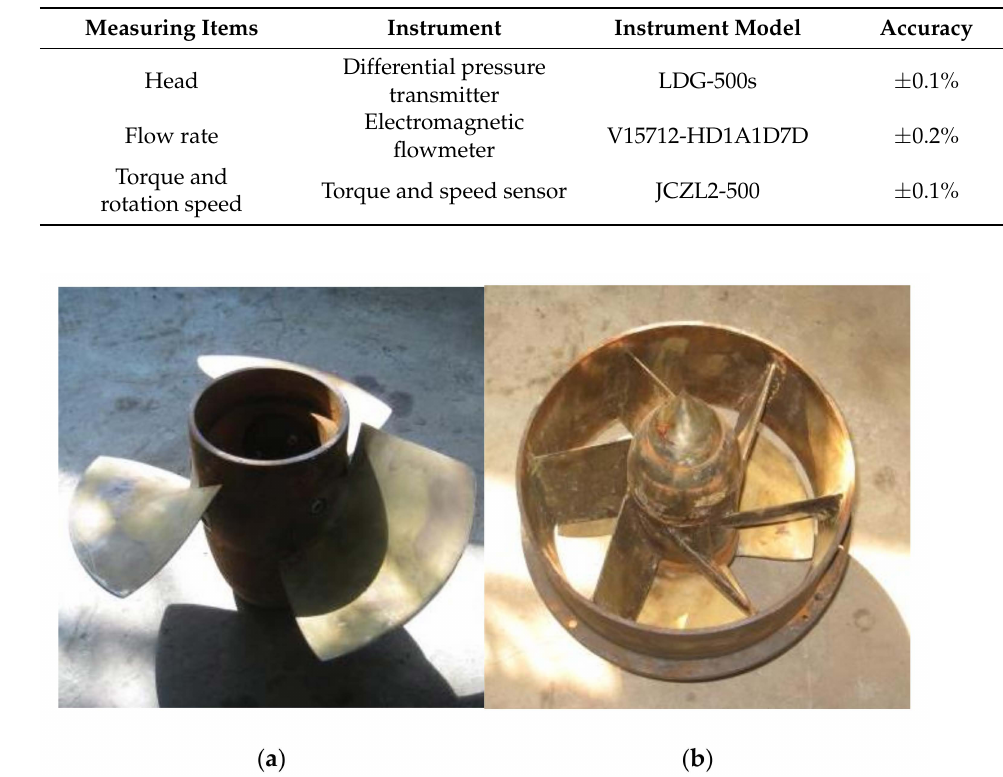
Table 3. Main test instruments of test bench.